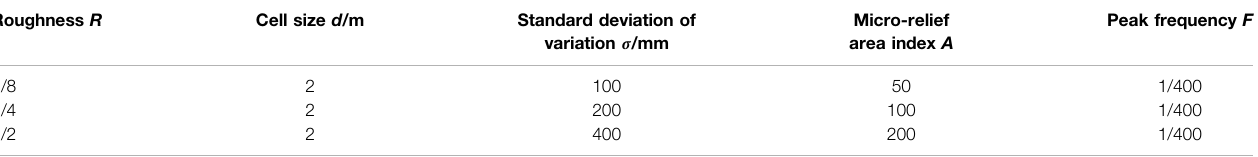
TABLE 1 | Standard deviation of variation, micro-relief area index, and peak frequency for each roughness practice Roughness R Cell size d /m Standard deviation of variation σ